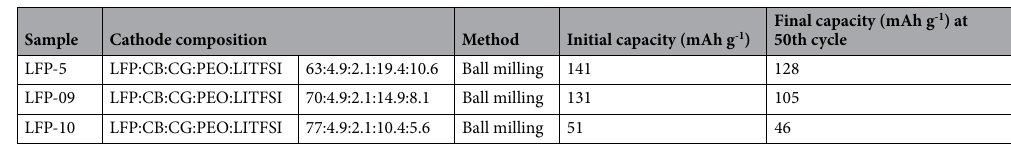
Table 4. Variation of LFP content keeping EO:Li = 12:1. The batteries were tested at 1C at 70 °C for 50 cycles using Li/SPNE/LFP configuration.